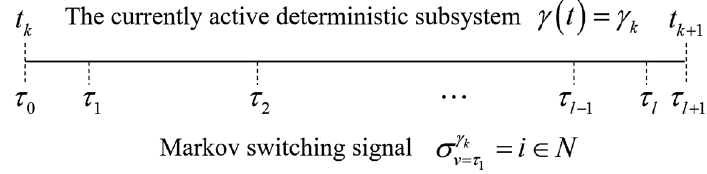
Figure 2. Stochastic switching timing